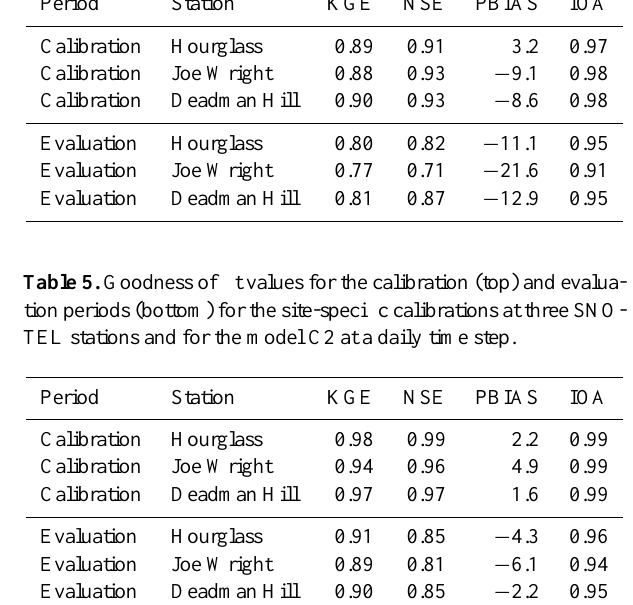
Figure 6. Calibration and evaluation model results for station- specificcalibrationtestinHourglassstation:thegraydotsrepresent themeasuredSWE,thesolidredlinerepresentsthemodelC1(clas- sicaltemperature-indexmodel)andthebluesolidlinerepresentsthe modelC2(CazorziandDallaFontana).